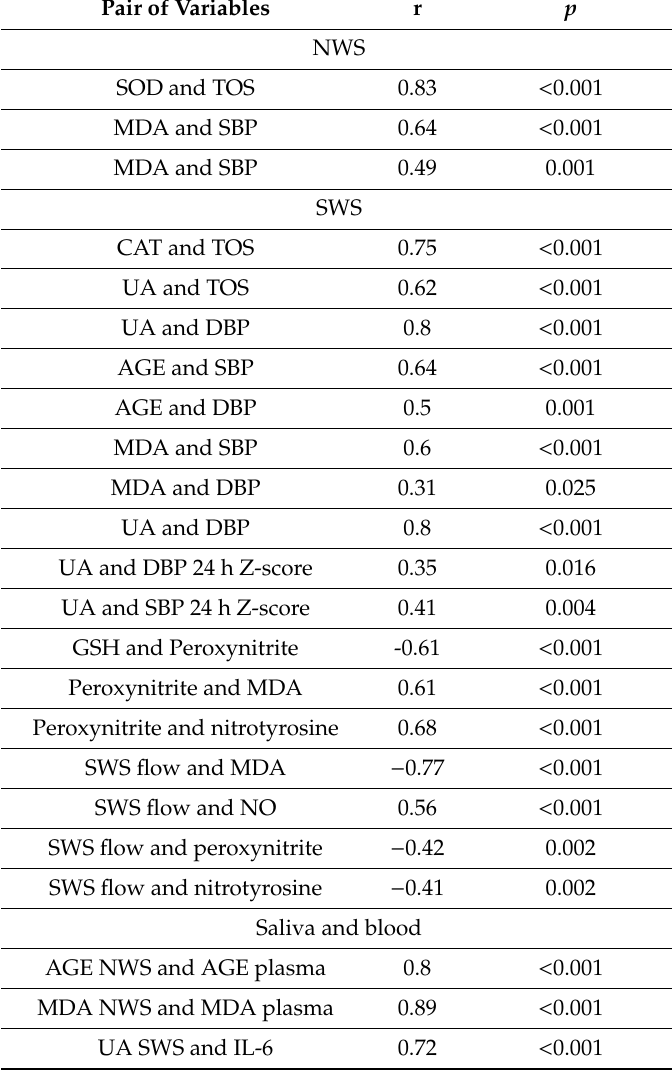
Table 5. Correlations between salivary redox biomarkers and clinical characteristics in children with